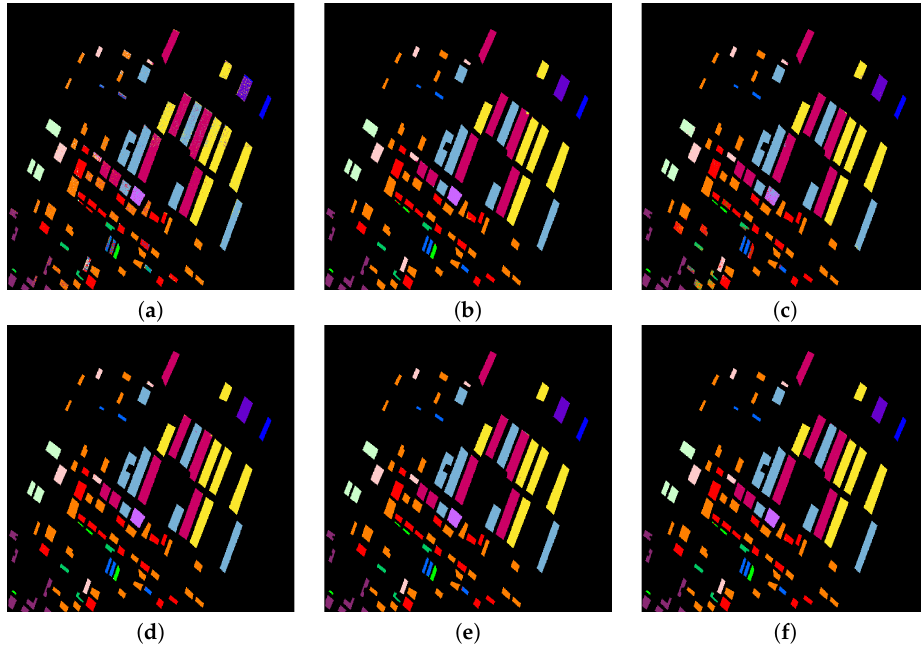
Figure 19. Classification maps resulting from the Flevoland Benchmark data set with different algorithms. ( a ) BSLGDA: 92.80%; ( b ) FCN: 97.45%; ( c ) PCA + FCN: 96.49%; ( d ) BLGDA + FCN: 99.71%; ( e ) BSGDA + FCN: 99.79%; ( f ) BSLGDA + FCN: